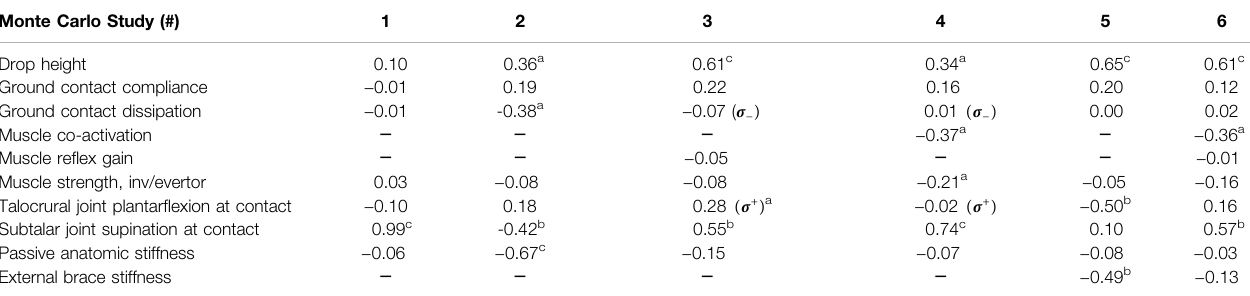
TABLE 2 | Correlations between probabilistic input parameters and peak subtalar supination angle within six Monte Carlo simulations. Input parameter distributions are provided in ( Table 1 ). Probabilistic sensitivity factors were additionally computed to assess independent in fl uences of input parameter mean and variance on response mean and variance, and generally agreed with correlations, with exception of ( σ + − ) indicating an increase in the parameter mean increased (+) or decreased (-) variance in the response. Supplementary Figure S6, S7 ). Monte Carlo Study (#)